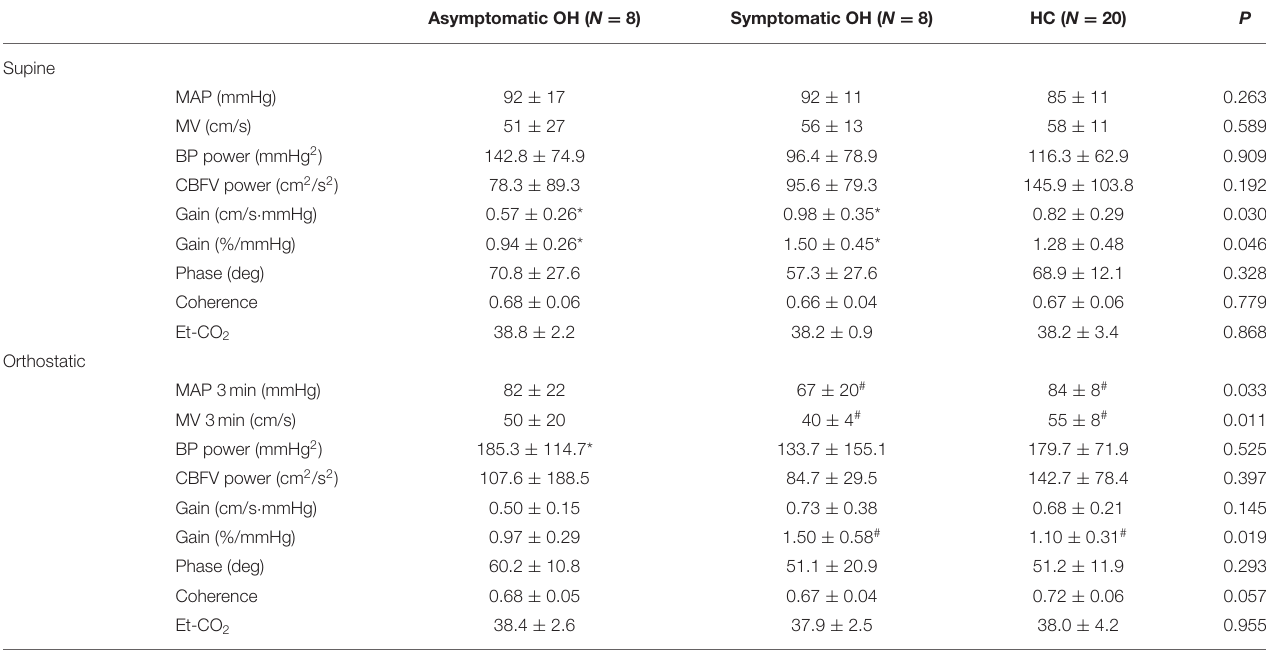
TABLE 5 | Cerebral autoregulation parameter in symptomatic patients with